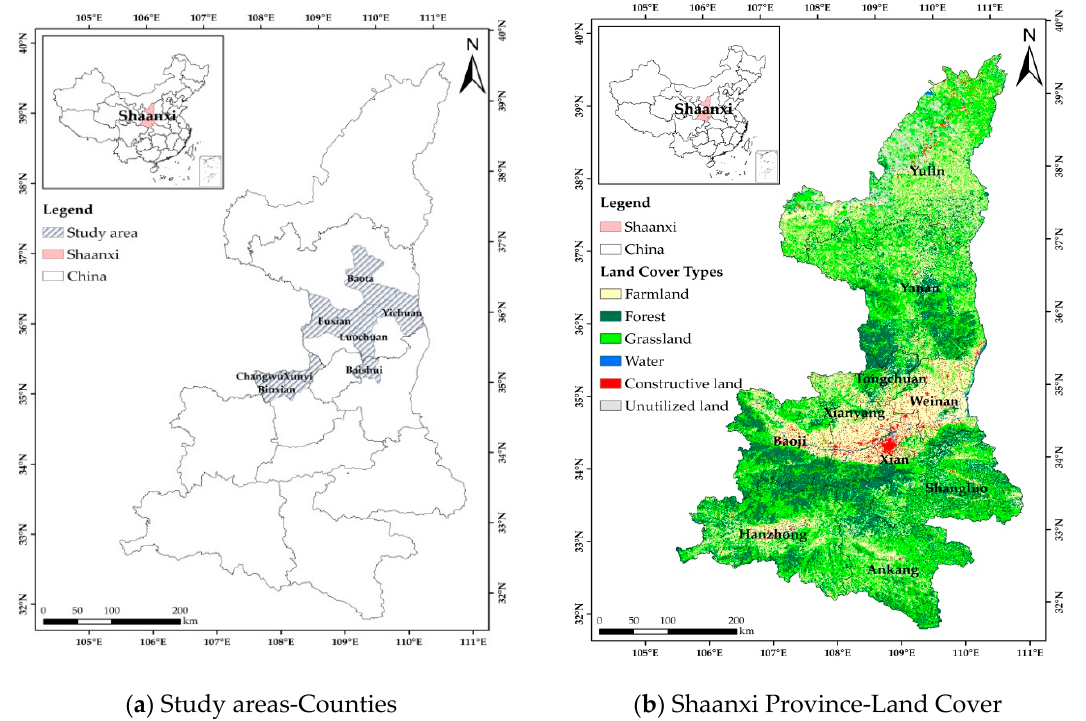
Figure 2. The study area in the Shaanxi province.